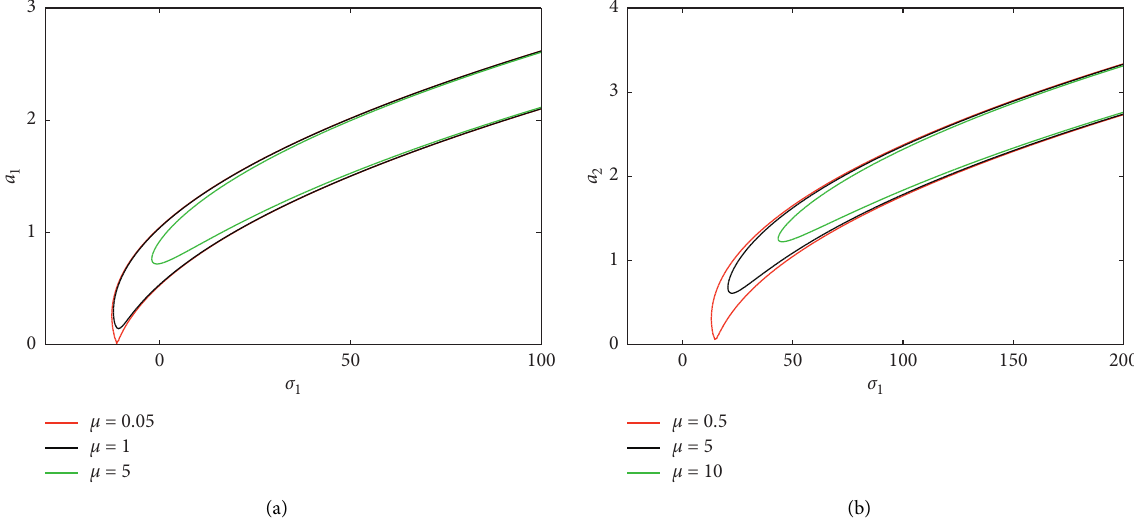
Figure 3: Amplitude-frequency response curves of the first-order and the second-order mode for different damping